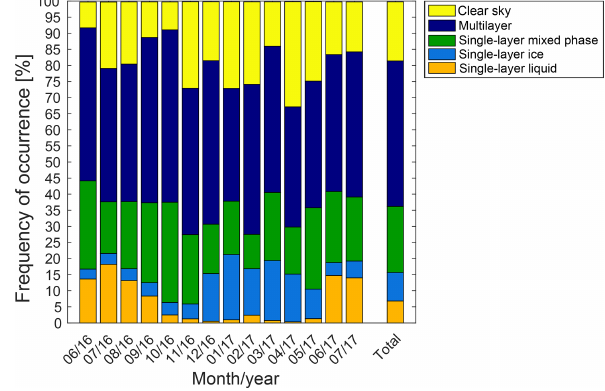
Figure 9. Monthly frequency of occurrence of different types of single-layer clouds (liquid, ice, and mixed phase), multilayer clouds, and clear-sky profiles for the period from June 2016 to July 2017. The last right column shows the total frequency of oc-